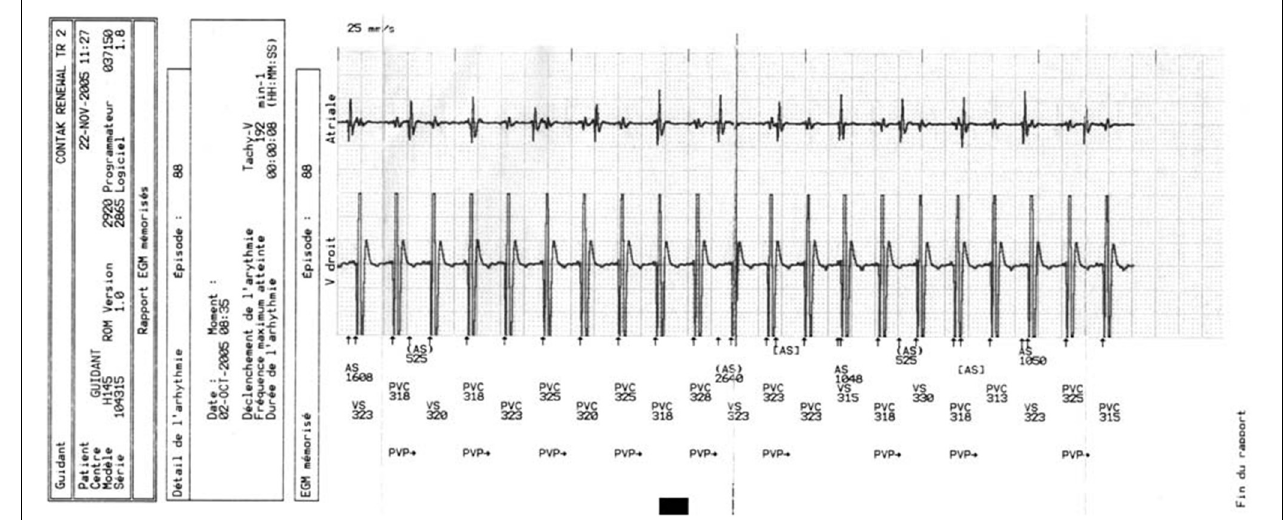
FIGURE 1 | A device interrogation printout showing ventricular